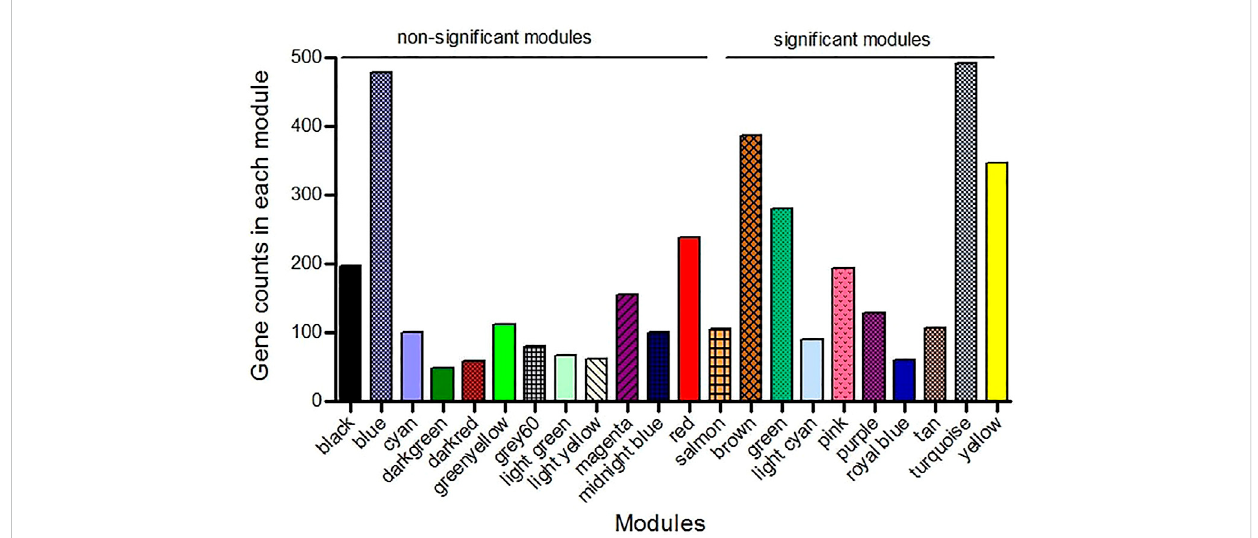
FIGURE 4 Theresultofweighted geneco-expressionnetwork analysis (WGCNA)that detected22modules inwhich theco-expressedgenesweregrouped in the same modules. The nine signi fi cant modules ( p -value < 0.05) were speci fi ed from the non-signi fi cant modules.